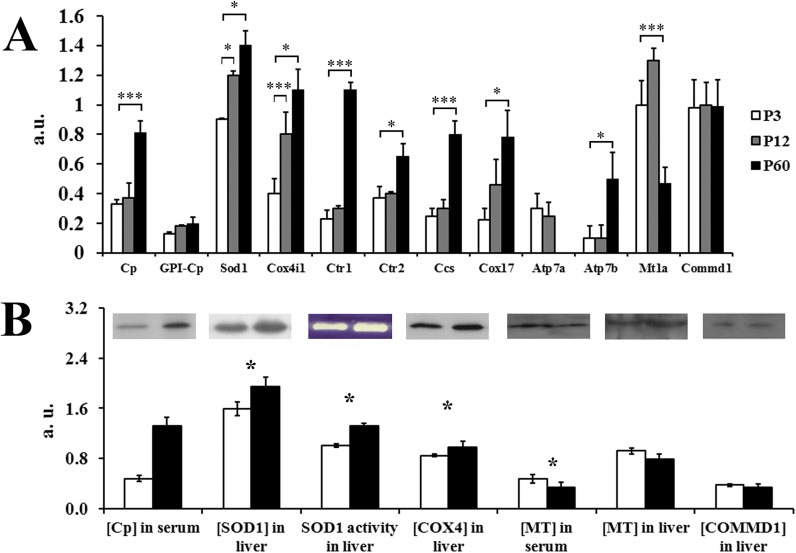
Hepatic expression of the genes associated with copper metabolism during ETCM→ATCM transition.(A) RT-PCR analysis of the relative levels of mRNAs. Ordinate axis: the data expressed as a. u., the means ± SD (n = 4); *—P<0.05, **—P<0.01, ***—P<0.005. Light bars–P3, grey bars–P12, black bars–P60. (B) Western blot analysis of the relative content of proteins associated with copper metabolism. Upper: examples of WB and SOD activity protocols. The molecular weight of WB identified proteins corresponds to: Cp ∼130 kDa (8% SDS-PAGE), SOD1 ∼17 kDa (12% SDS-PAGE), COX4 ∼20 kDa (12% SDS-PAGE), MT ∼8 kDa (15% SDS-PAGE), COMMD1 ∼23 kDa (12% SDS-PAGE); SOD activity was identified by gel-assay (blue gel) as described in Methods. Below: densitometric quantification of WB and SOD1 activity data. Abscissa axis: relative protein content, a. u., the means ± SD (n = 4). Light bars–P9, black bars–P60 rats.